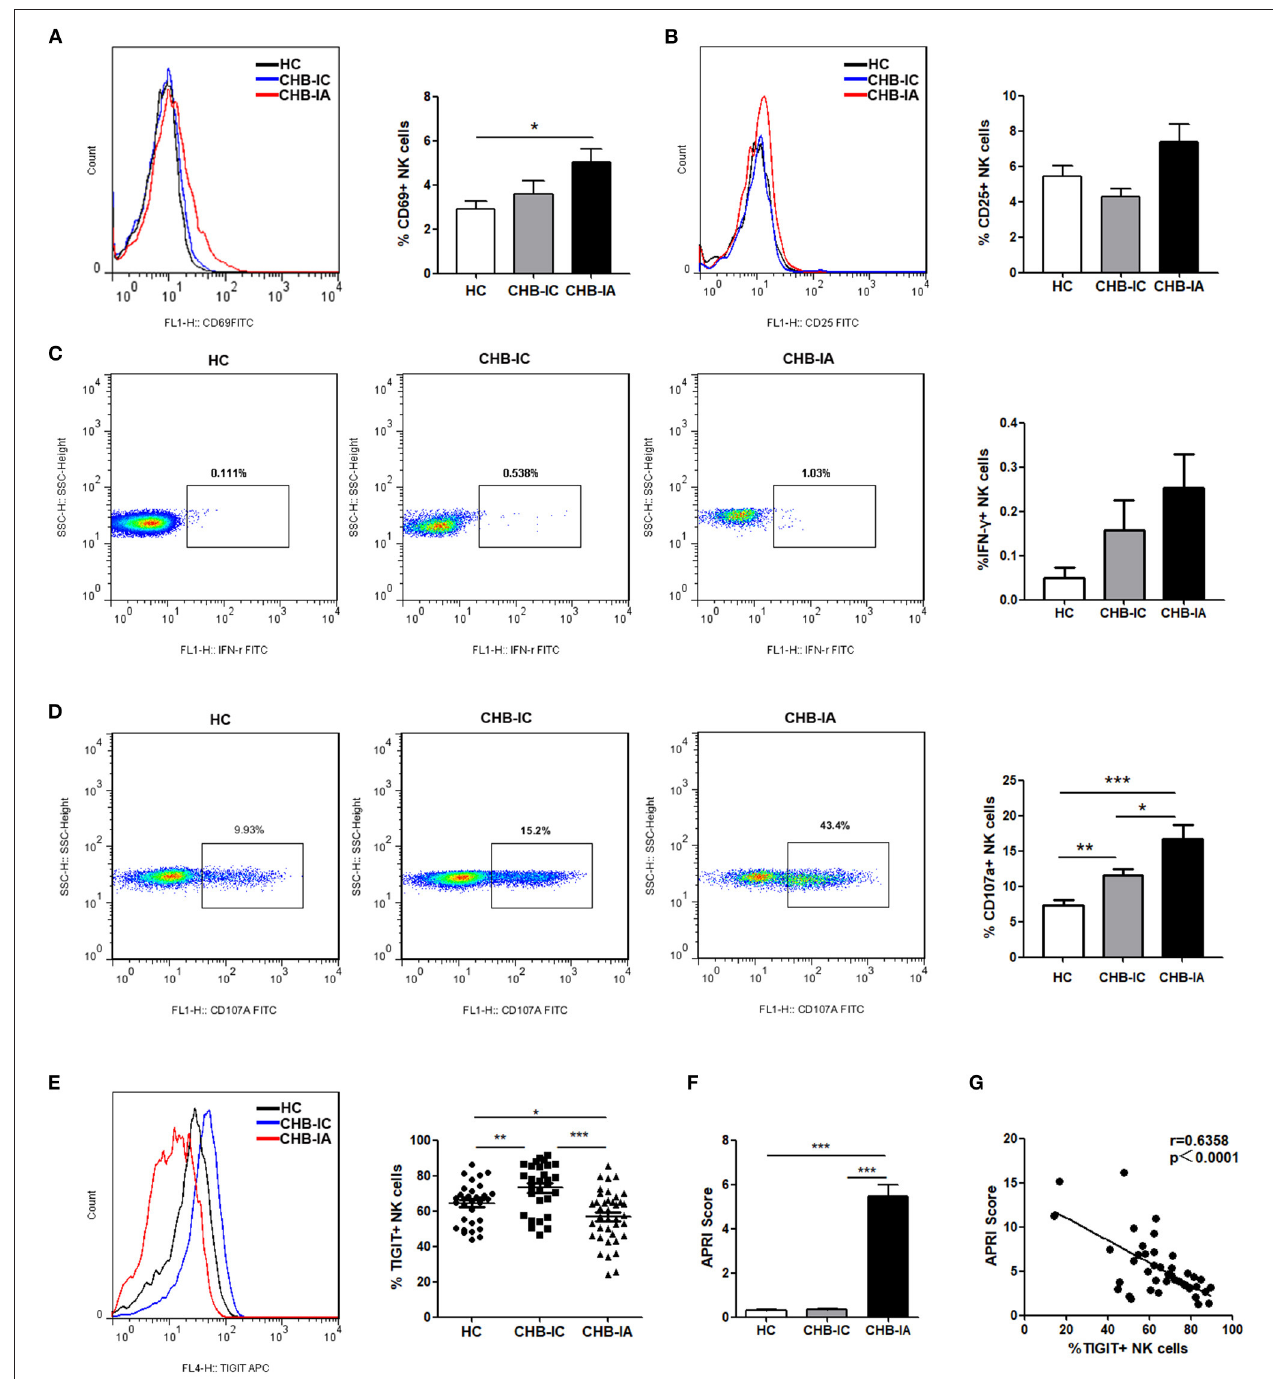
FIGURE 1 | NK cells phenotype and TIGIT levels in the three groups of patients. (A–C) PBMCs isolated from CHB-IA, CHB-IC, and healthy individuals were analyzed by flow cytometry without any stimulate. Representative FACS histograms showing the expression of CD69 (A) or CD25 (B) on peripheral blood NK cells. The mean fluorescence intensity (MFI) of CD69 (A) or CD25 (B) is shown as mean ± SEM (n = 7 ∼ 12). (C) Representative FACS plots showing the production of IFN- γ in peripheral blood NK cells without stimulation. The percentages of IFN- γ is also shown as mean ± SEM (n = 10 subjects per group, right). (D) The PBMCs isolated from the three groups were stimulated with IL-12 for 24h with K562 as target cells. Representative FACS plots showing the expression of CD107a on peripheral. The percentages of CD107a + NK cells are shown as mean ± SEM (n = 16–23 subjects per group) (Mann-Whitney U test). (E) Representative FACS histograms showing the expression of TIGIT on peripheral blood NK cells. The mean fluorescence intensity (MFI) of TIGIT is also shown as mean ± SEM (n = 10 subjects per group, right). (F) APRI score in the three groups is shown as the mean ± SEM (n = 9 subjects per group). Data are from a single experiment representative of three. *** p 0.001 (Student’s t-test). (G) Correlation between TIGIT and APRI scores expression on NK cells in CHB patients is shown (Spearman’s rank correlation test). Each symbol represents an individual donor. Data are from a single experiment representative of three. * p < 0.05, ** p < 0.01, *** p < 0.001.